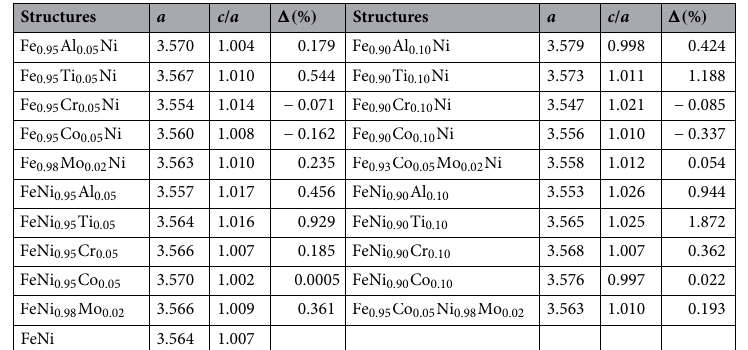
Table 1. The lattice parameters (in units of Å) of Fe 1 − x M x Ni and FeNi 1 − x M x ( x = 0.05 , 0.10) ( M = Al , Ti, Cr, Co), and Fe 0.98 Mo 0.02 Ni , FeNi 0.98 Mo 0.02 , Fe 0.93 Co 0.05 Mo 0.02 Ni and Fe 0.95 Co 0.05 Ni 0.98 Mo 0.02 as a function of chemical composition for L 1 0 structures ( η = 1) and the volume changes relative to undoped L1 0 FeNi V − V FeNi expressed as (cid:31) = V FeNi × 100% .